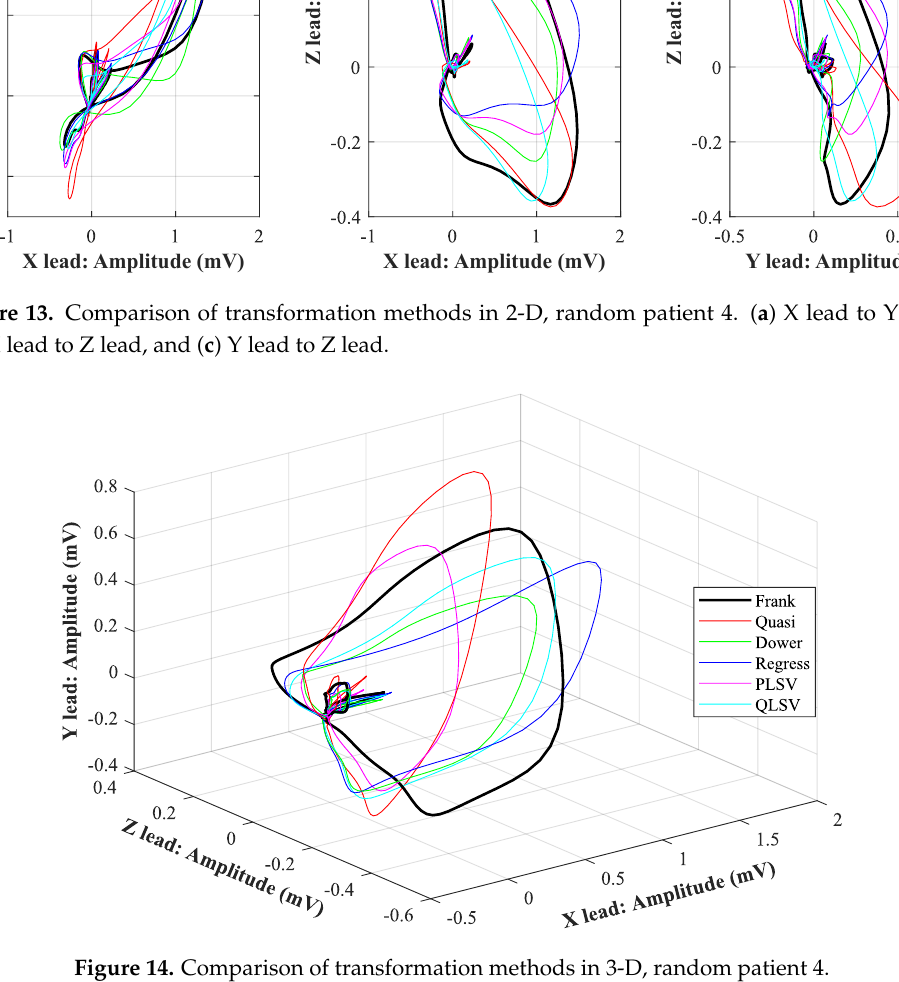
Figure 14. Comparison of transformation methods in 3-D, random patient